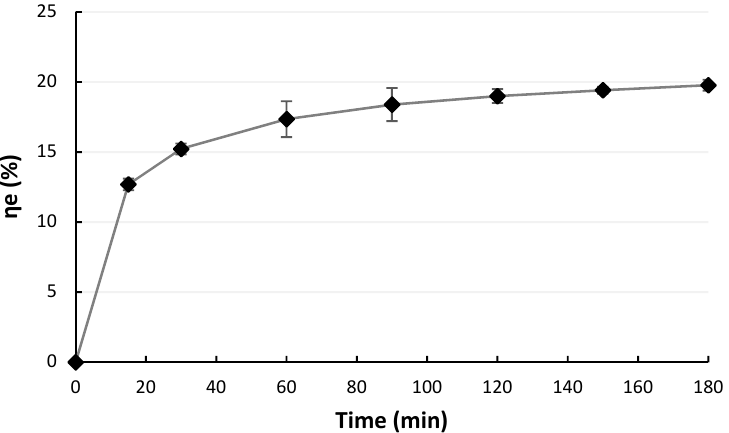
Figure 2. Extraction yield of hop extracts ( η e ) evaluated during the extraction process carried out using Norflurane solvent.